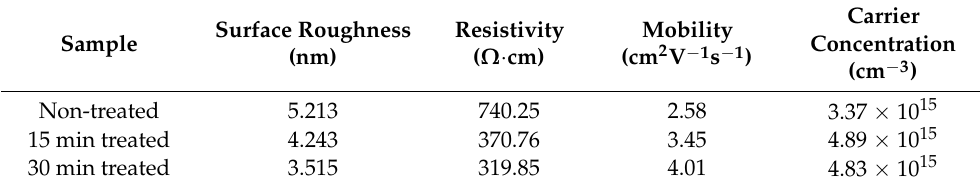
Table 1. Surface roughness, resistivity, mobility, and carrier concentration parameters obtained from Hall measurement and